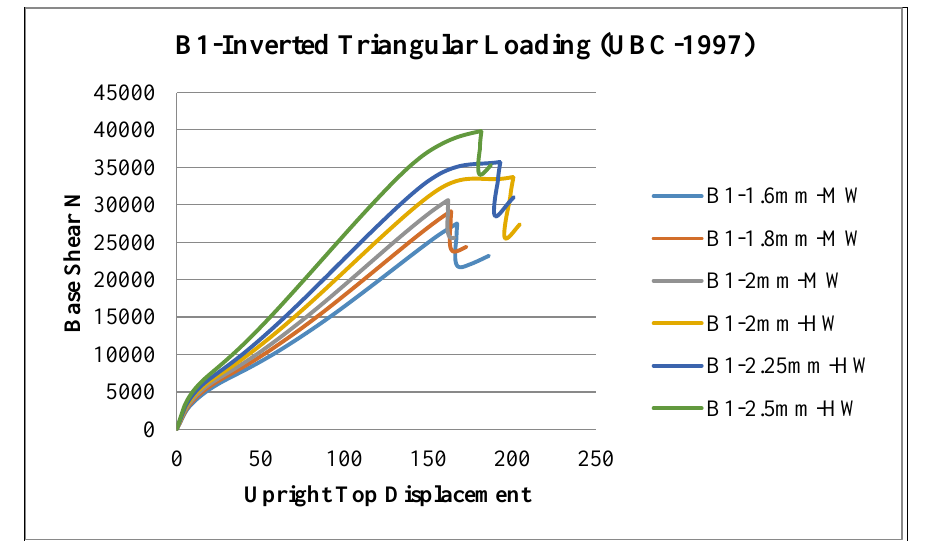
Fig. 11. Base shear verses upright top displacement for B1 (UBC-1997)